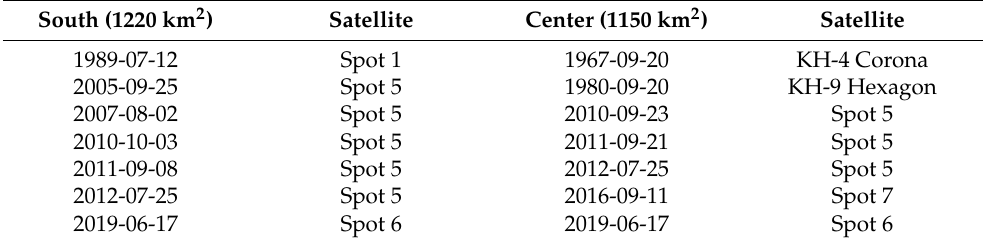
Table 2. Dates of scenes and satellite platform used in each study